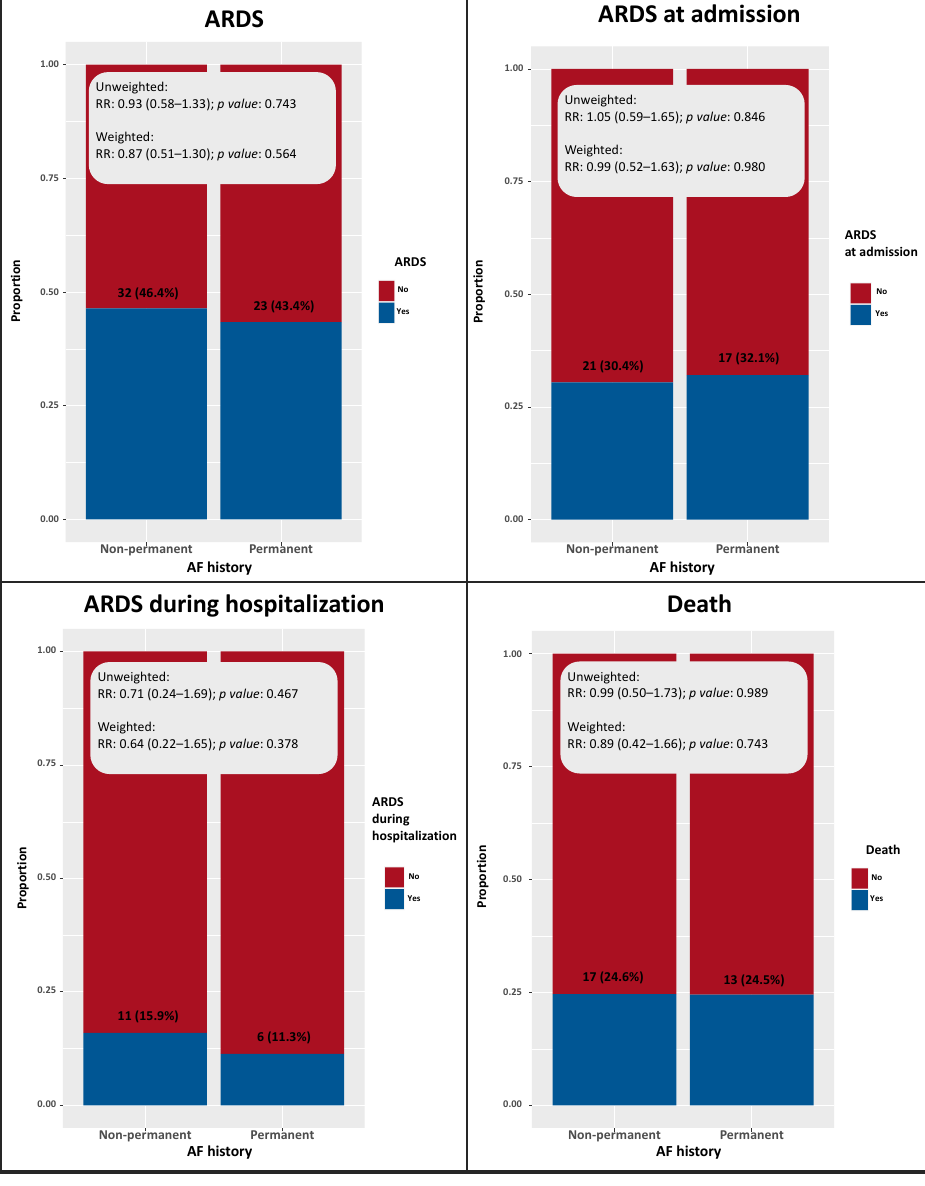
Figure 4. Prevalence and risk ratio of the outcome of interest among patients with non-permanent and permanent AF history.